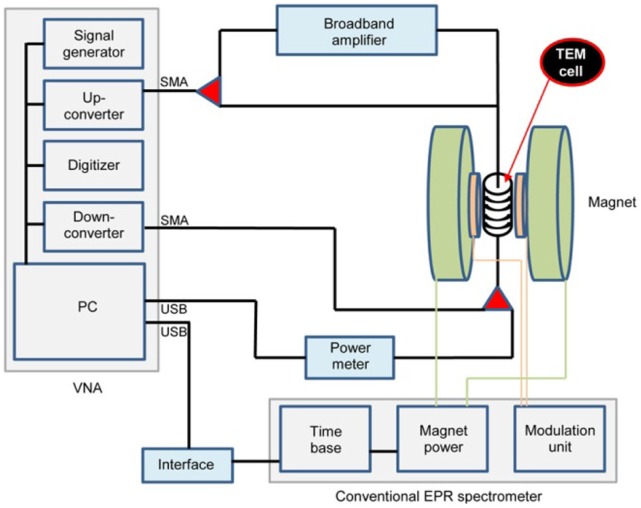
Outline of the transmission EPR spectrometer.An arbitrary microwave produced in the vector network analyzer (VNA) is send – either directly or via a broadband amplifier – to a transmission cell placed in the electromagnet of a conventional EPR spectrometer. The sample-attenuated output of the cell is either detected in a broadband power meter or as a carrier amplitude by the VNA. The time base of the magnet is used to trigger the onset of signal detection. The modulation coils of the magnet are employed in rapid-scan EPR.